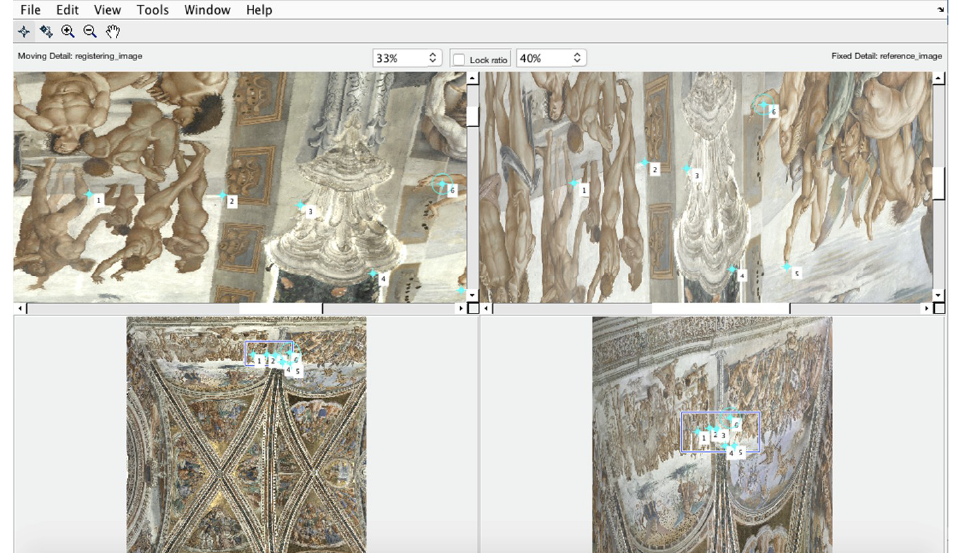
Figure 10. Procedure for the registration of textures by picking similar points for the elaboration of the 3D model of the San Brizio Chapel. (Elaboration carried out by ENEA team with the custom software itrAnalyzer).